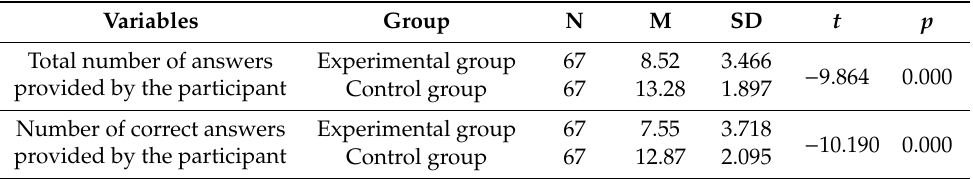
Table 4. Di ff erences in variables that distinguish executive functions in experimental and control groups.